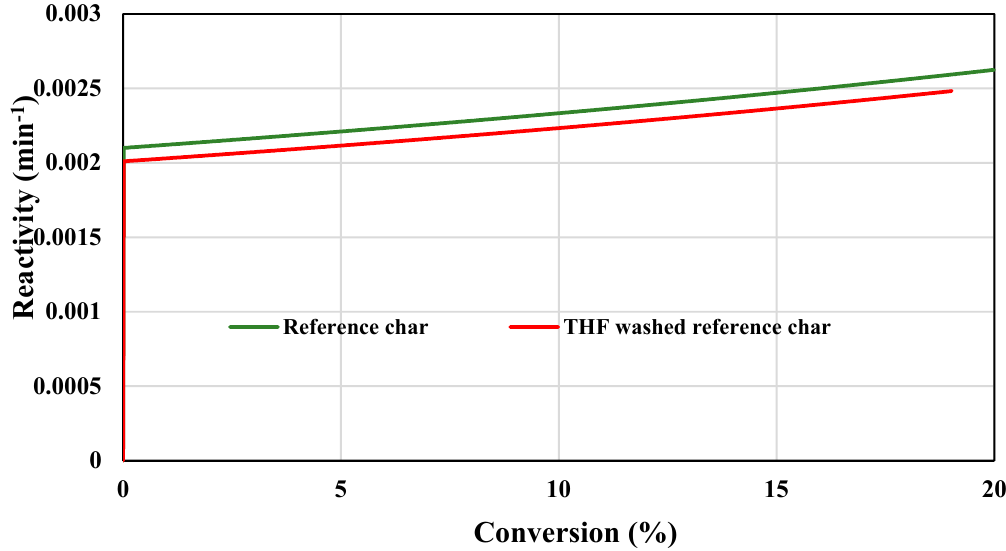
Figure 10. CO 2 reactivity of the reference char and the THF washed reference char. Table 6. Compounds identified by the GC-MS.